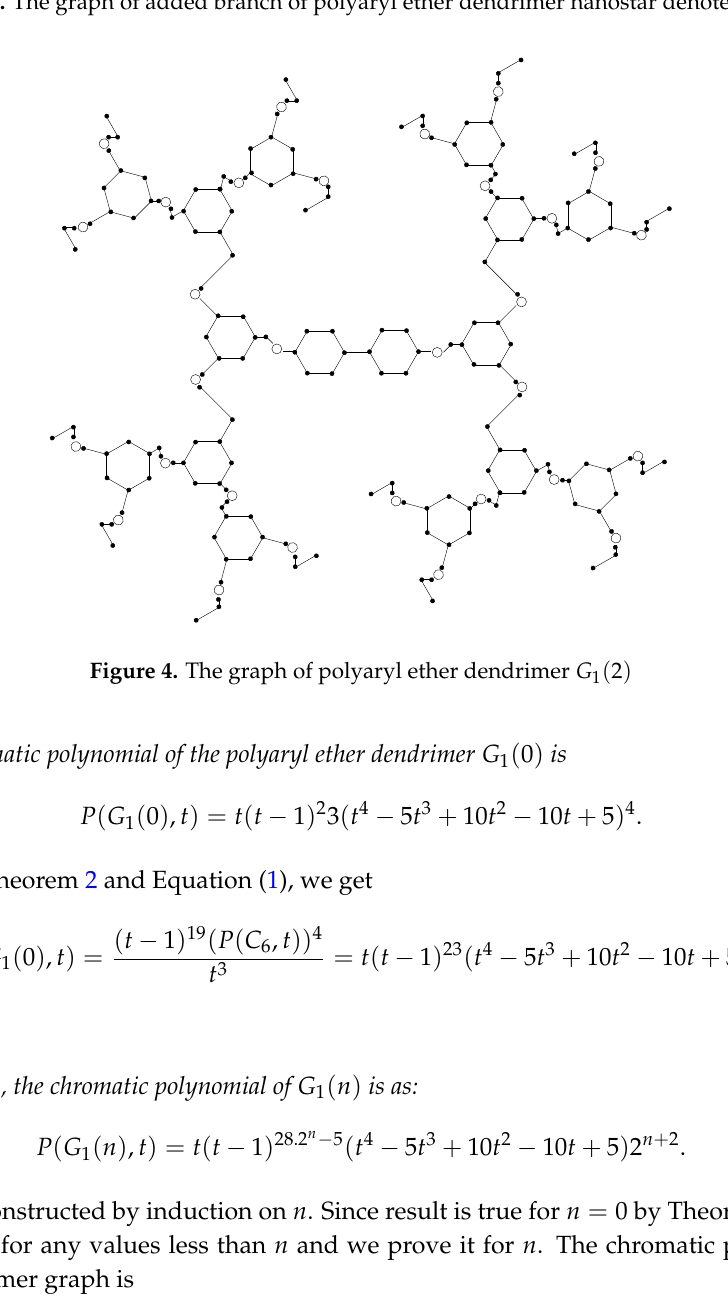
Figure 3. The graph of added branch of polyaryl ether dendrimer nanostar denoted by H .